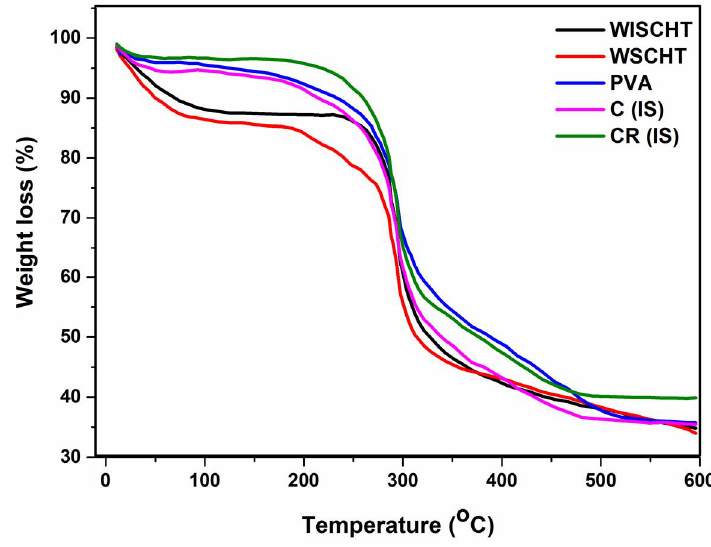
Figure 5. Thermogravimetric Analysis (TGA) of prepared samples.